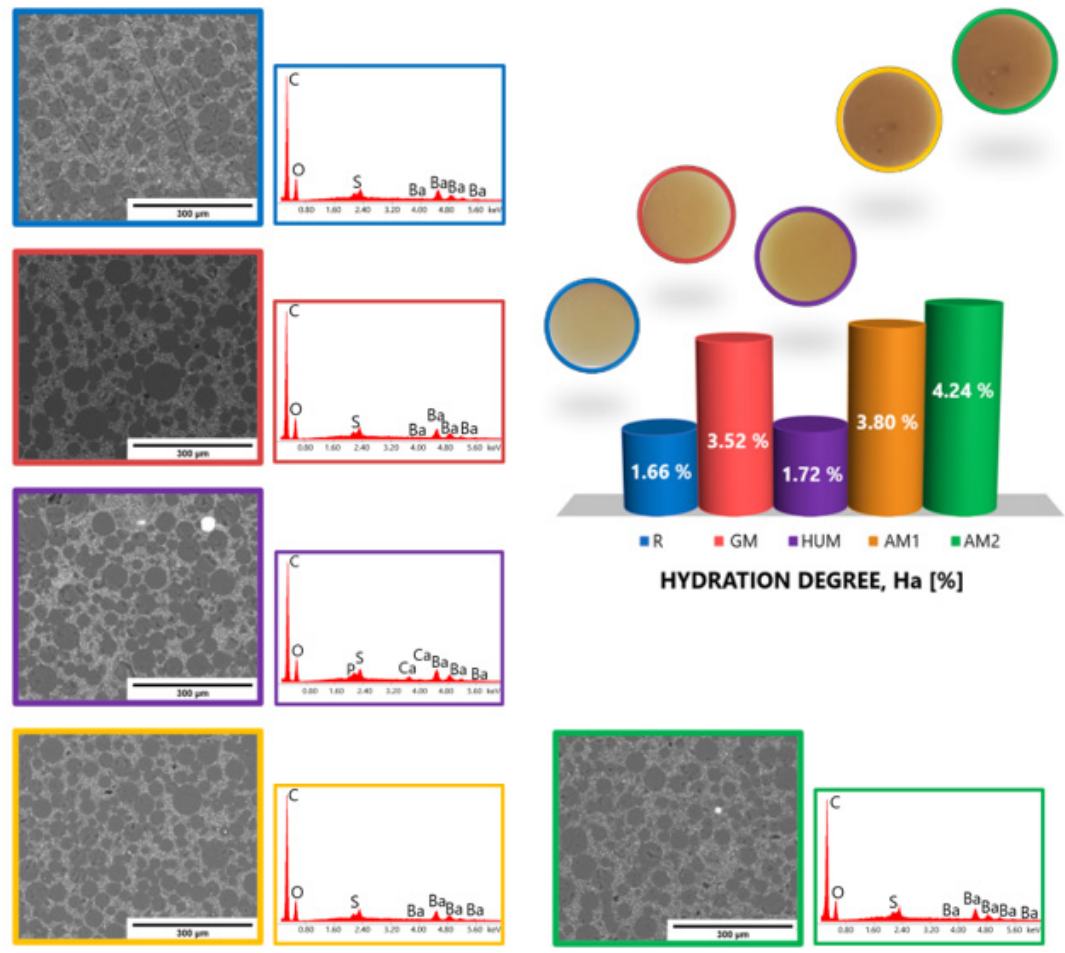
Figure 5. Morphological aspects revealed by SEM and elemental surface analysis by EDS of the samples after 21 days in distilled water .